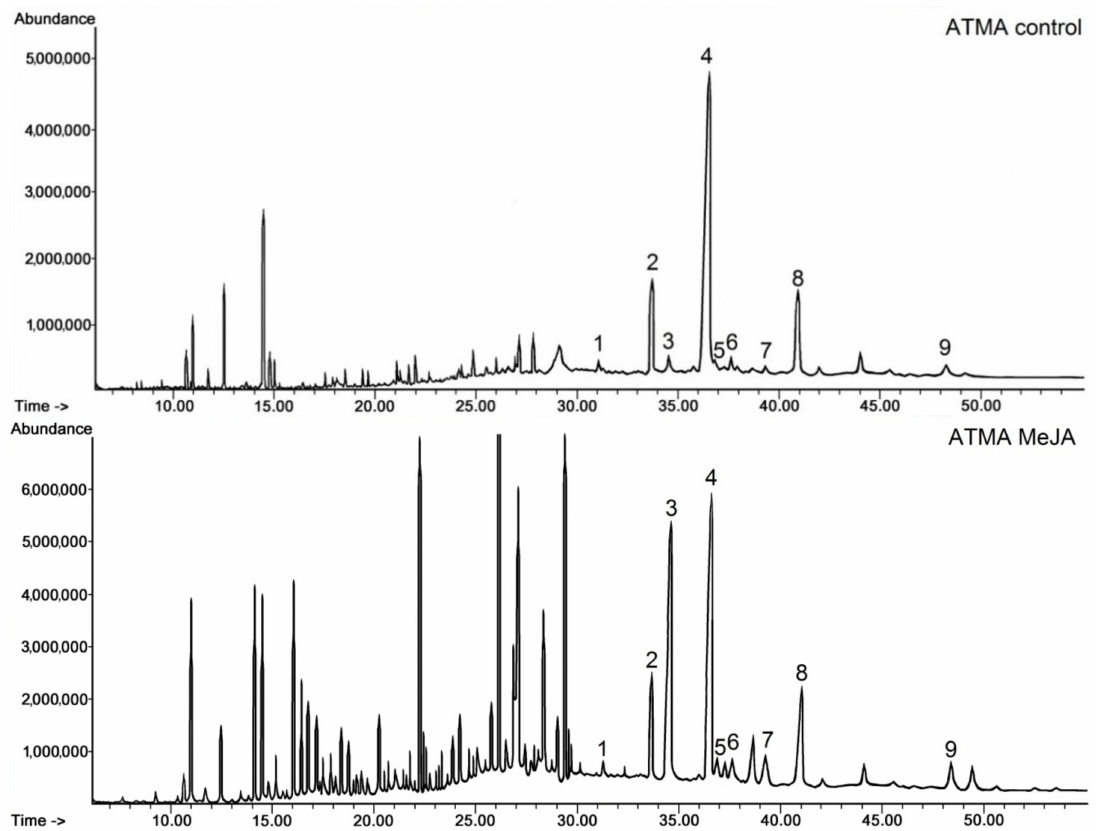
Figure 5. Chromatograms of the fractions containing free steroids from diethyl ether extracts obtained from the control and elicited ATMA line hairy roots. 1, cholesterol; 2, campesterol; 3, stigmasterol; 4, sitosterol; 5, isofucosterol; 6, campestanol; 7, tremulone; 8, sitostenone; 9,